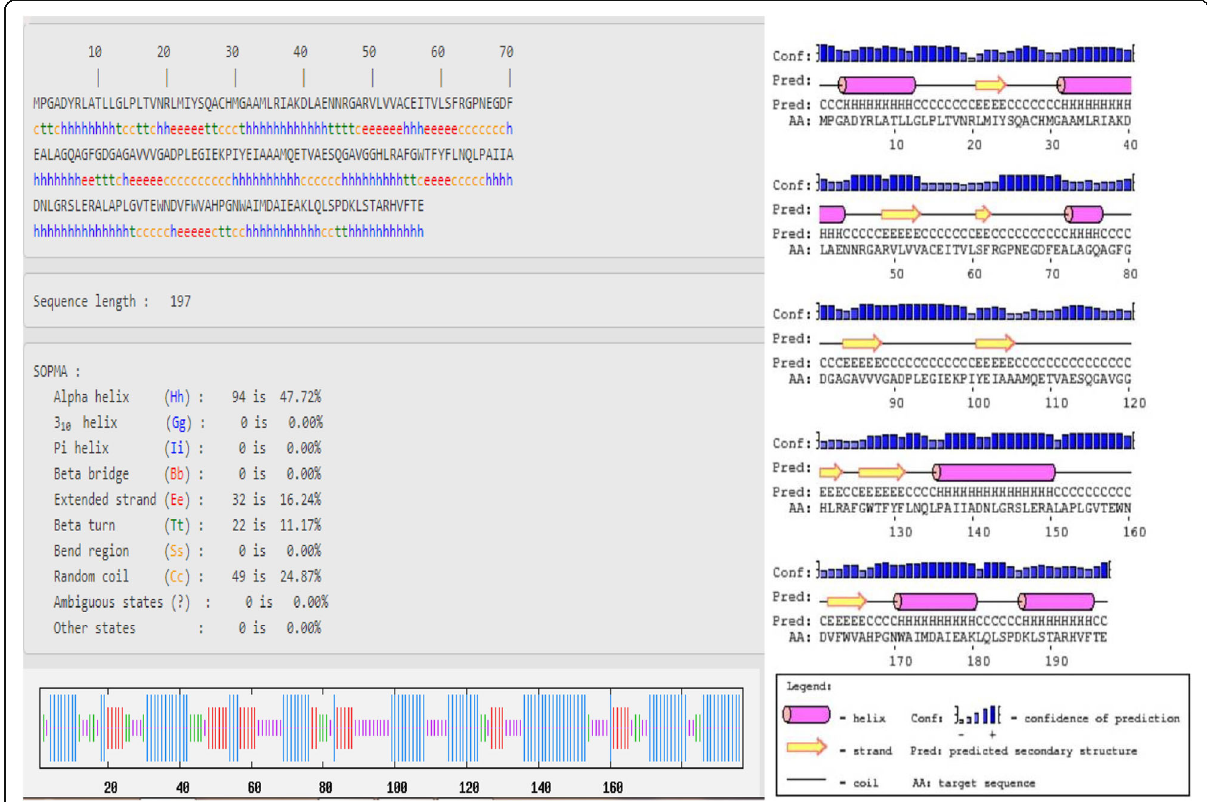
Fig. 1 Secondary structure analysis of C. longa